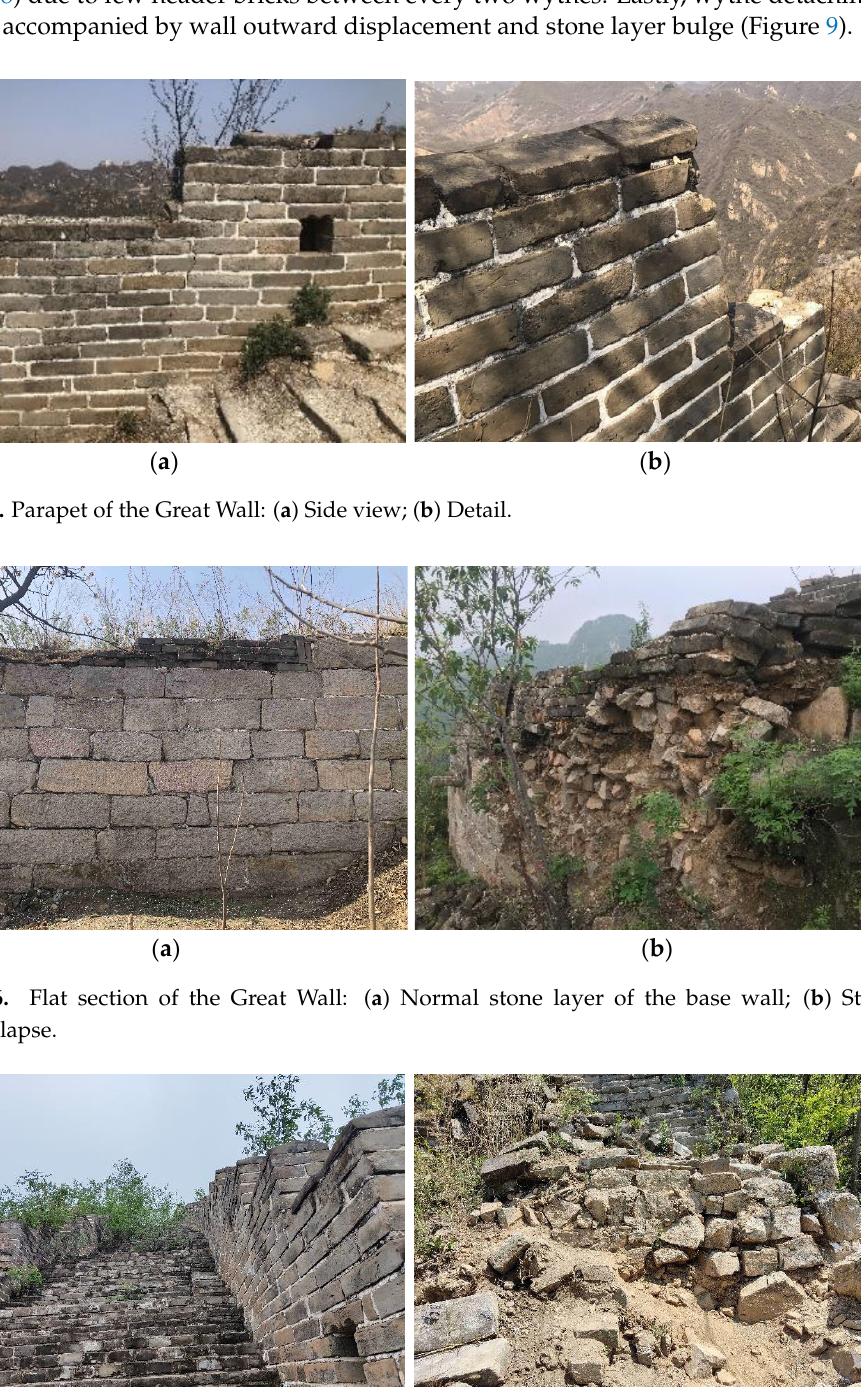
Figure 6. Flat section of the Great Wall: ( a ) Normal stone layer of the base wall; ( b ) Stone layer collapse.